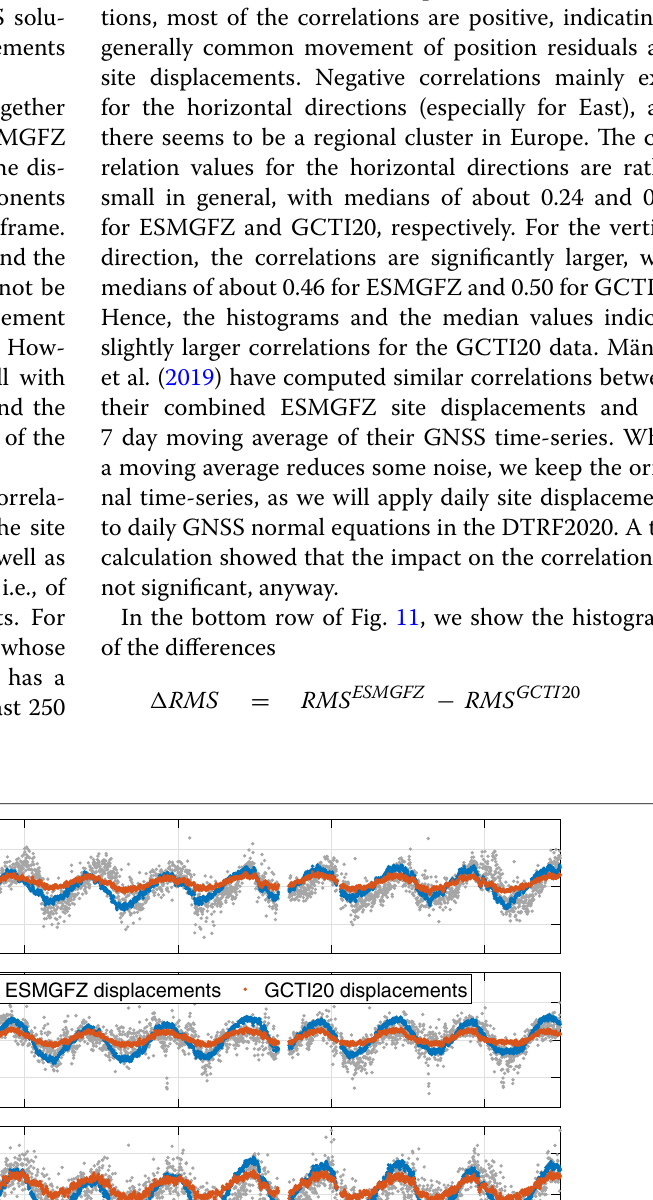
NTOL HYDL [ SLEL]) non-tidal loading site displacements from the CF-frame provided + + +